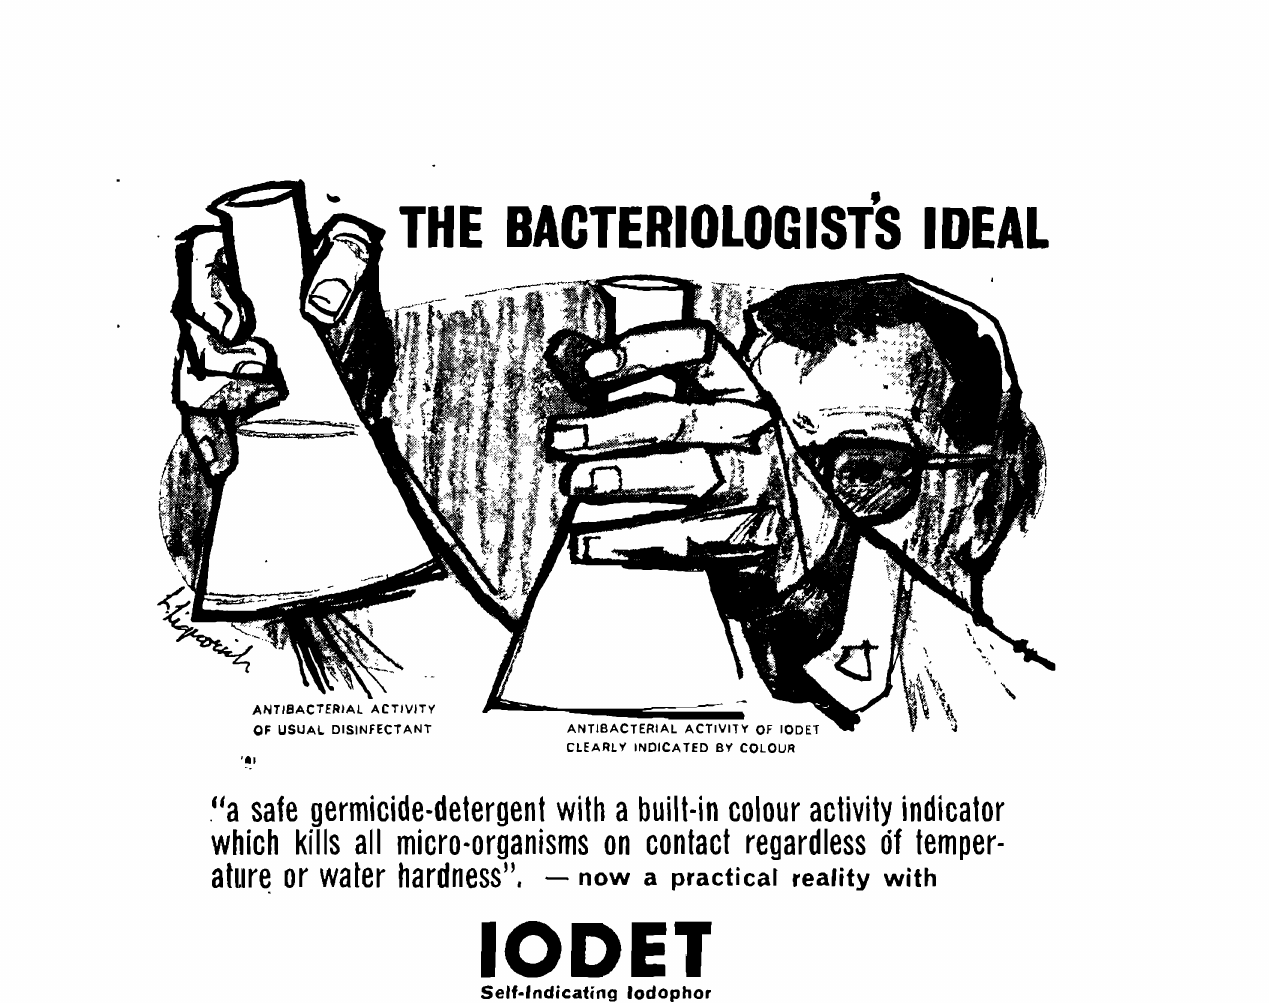
struments, furniture, floors, clothes